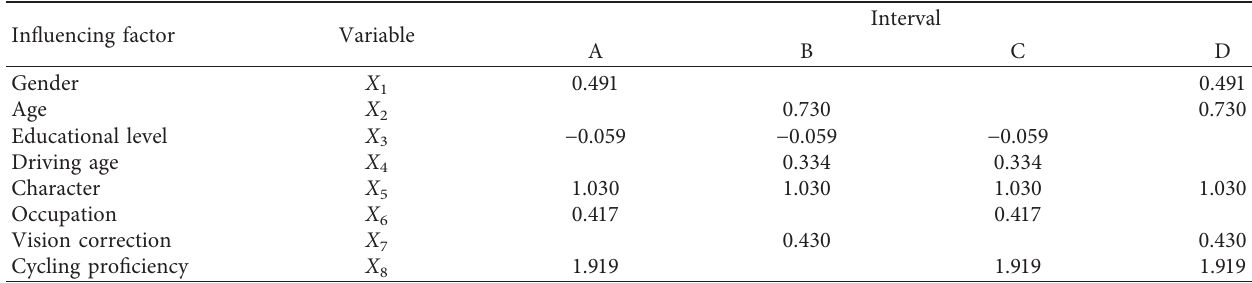
Table 8: Influencing factors and parameter